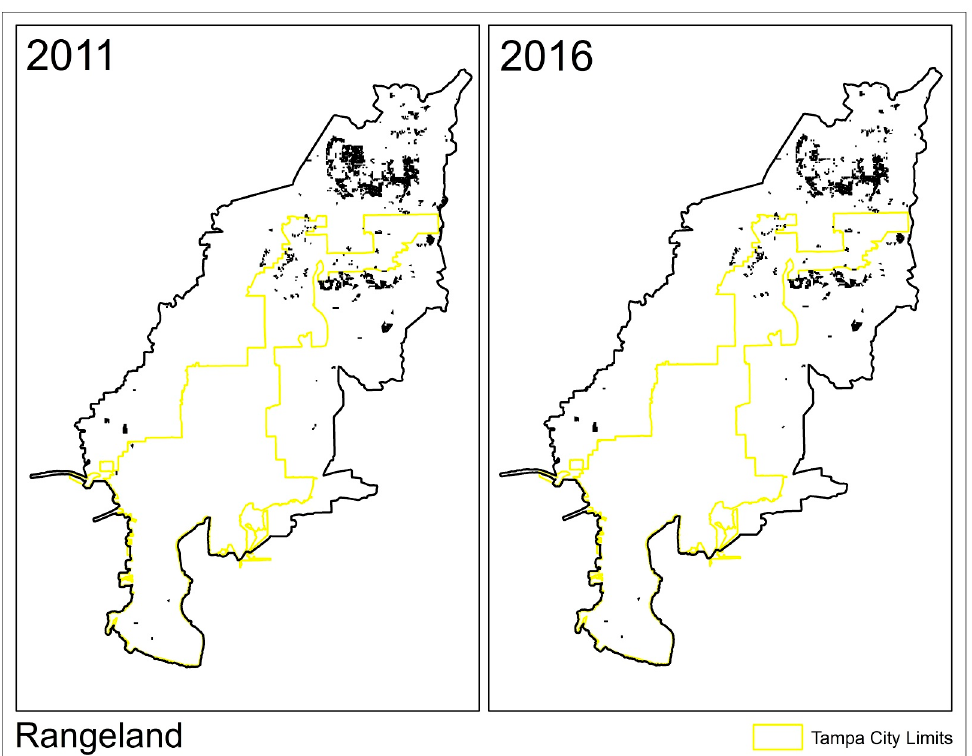
Figure A7. Observed (2011) and Modeled (2016) LULC distribution for the “Rangeland” class.